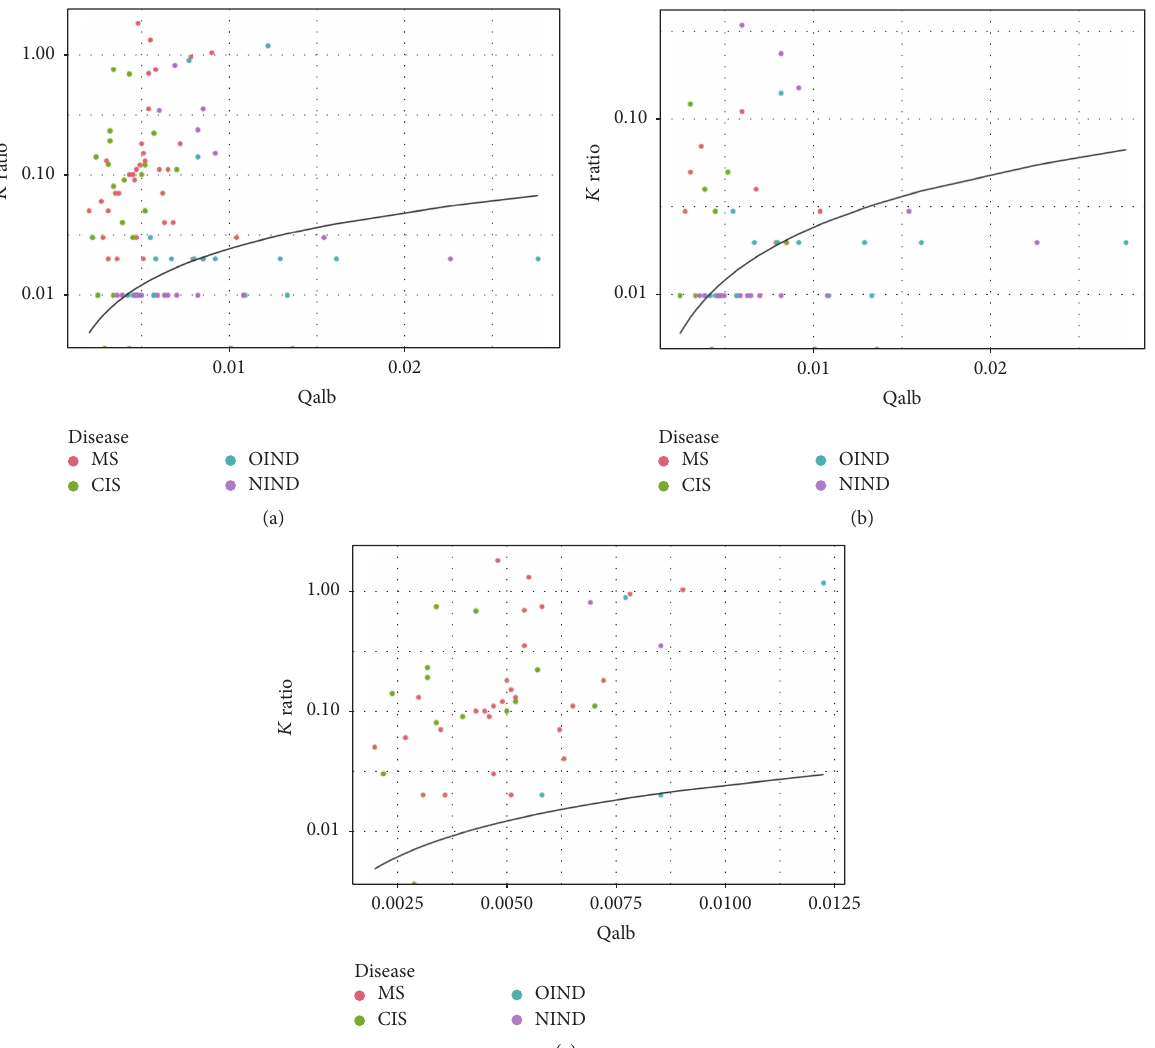
intrathecal inflammation ( 𝑝 < 0.001 for all